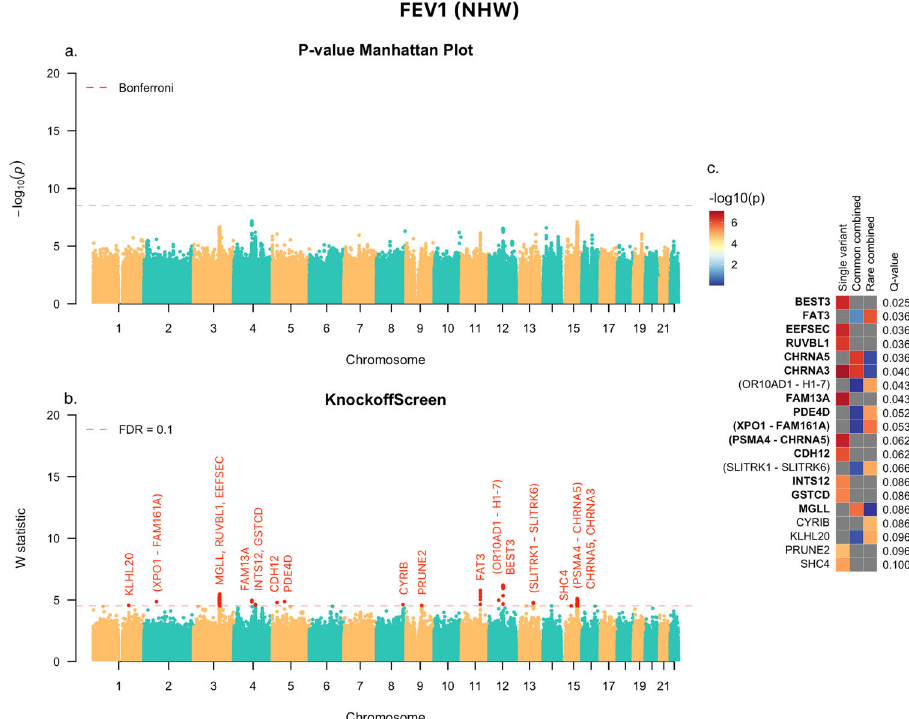
Fig. 7 KnockoffScreen application to the COPDGene study in TOPMed to identify variants associated with FEV 1 in Non Hispanic White (NHW). a Manhattan plot of p -values from the conventional association testing with Bonferroni adjustment ( p < 0 : 05/number of tested windows) for FWER control. b Manhattan plot of KnockoffScreen with target FDR at 0.1. c Heatmap that shows strati fi ed p -values of all loci passing the FDR = 0.1 threshold, and the corresponding Q-values that already incorporate correction for multiple testing. The loci are shown in descending order of the knockoff statistics. For each locus, the p -values of the top associated single variant and/or window are shown indicating whether the signal comes from a single variant, a combined effect of common variants, or a combined effect of rare variants. The names of those genes previously implicated by GWAS studies are shown in bold (names were just used to label the region and may not represent causative gene in the region). Source data are provided as a Source Data fi le.